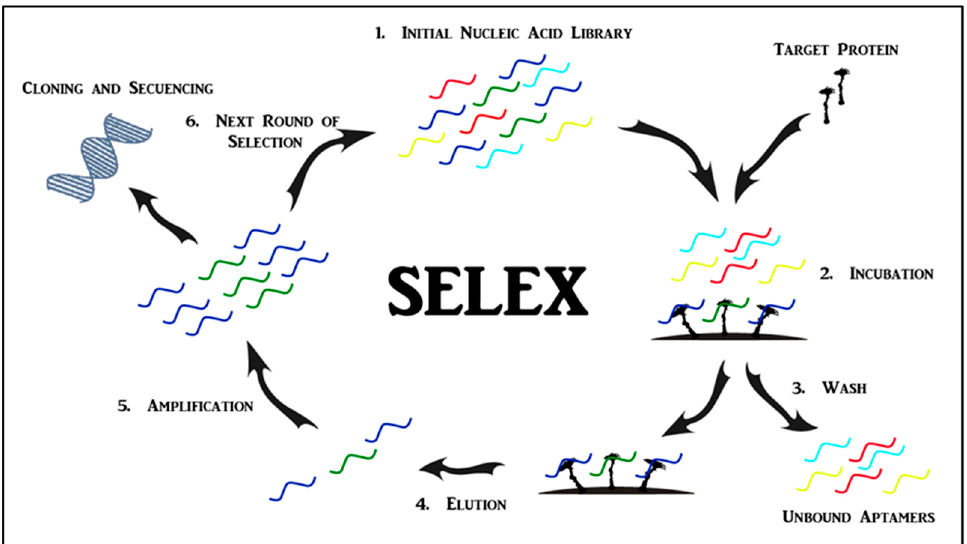
Figure 1. Systematic evolution of ligands by exponential enrichment (SELEX), for the generation of either single-stranded DNA or RNA oligonucleotides that bind to a target ligand. SELEX starts with the incubation of a nucleic acid library with the target protein. Unbound aptamers are washed off and protein-bound aptamers are eluted and amplified to create the library for the next round of selection. After iterative selection rounds, potential target-specific sequences are enriched and dominate the population of aptamers.